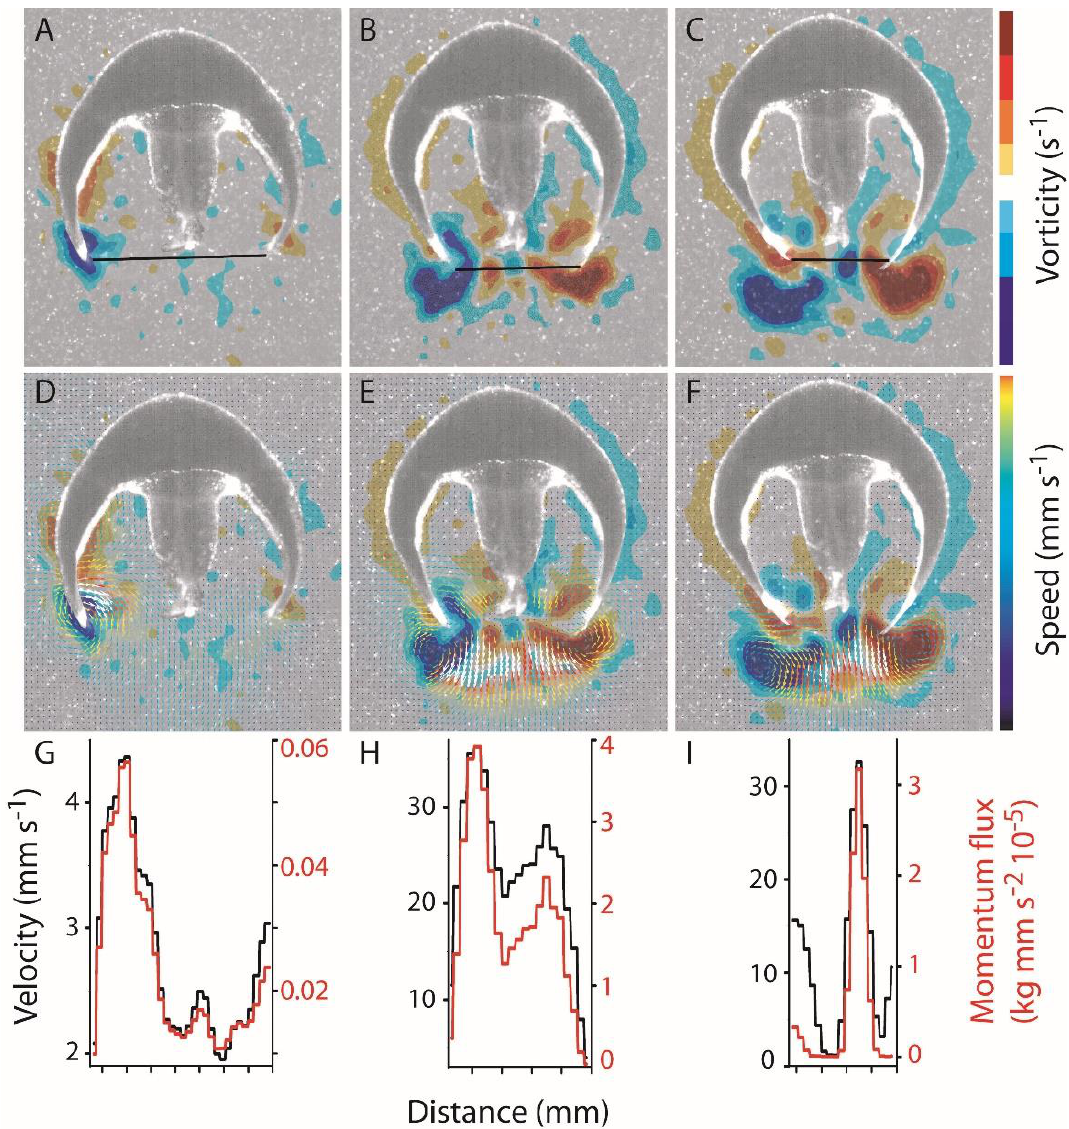
Figure 5. Body motions and vortex interactions during bell contraction by the hydromedusa Eutonina indicans. All data and animal images correspond to stages within the second pulsation cycle of Figures 2 and 3. Columns represent different stages of pulsation: Peak acceleration at initiation of bell contraction ( A,D,G ); peak change in combined starting vortex circulation ( B,E,H ); and peak change in maximum vector speeds of combined VIA jets ( C,F,I ). Columns represent different stages of pulsation: Rows of images represent different parameters for each of these pulsation stages: Vorticity ( A – C ); vorticity and vector speeds ( D – F ); and velocity and momentum flux across transects (straight black lines in panels ( A – C )) at the edge of the bell margins. The absolute values of vorticity and vector speeds varied throughout the pulsation cycle and, therefore, absolute magnitudes are not listed for the color scales of vorticity and vector speed. Note that momentum flux away from the animal corresponds to maximum flows at VIA regions of the wake and that VIA regions shift locations due to vortex movements during bell contraction. Momentum flux magnitude in ( G – I ) is given for each transect segment, as indicated by the discretization of the curves.